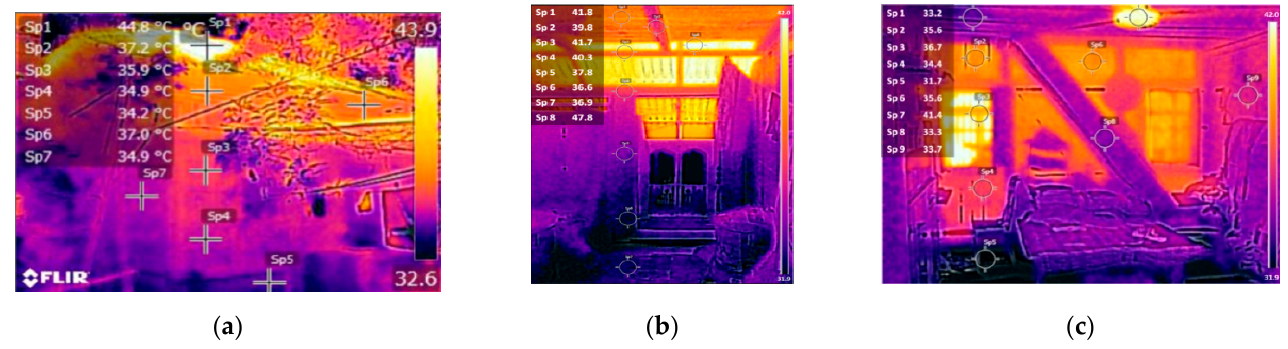
Figure 6. Surface temperature of H-2: ( a ) outdoors, ( b ) first and ( c ) ground floor.